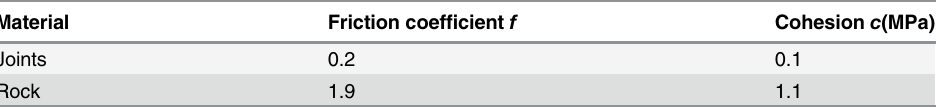
Fig 21. The rose diagrams of the persistence ratio k of jointed rock mass for the different slopes((a) The rose diagrams of the persistence ratio k of jointed rock mass for the first slope; (b) The rose diagrams of the persistence ratio k of jointed rock mass for the second slope) doi:10.1371/journal.pone.0121850.g021 Table 5. The parameters of